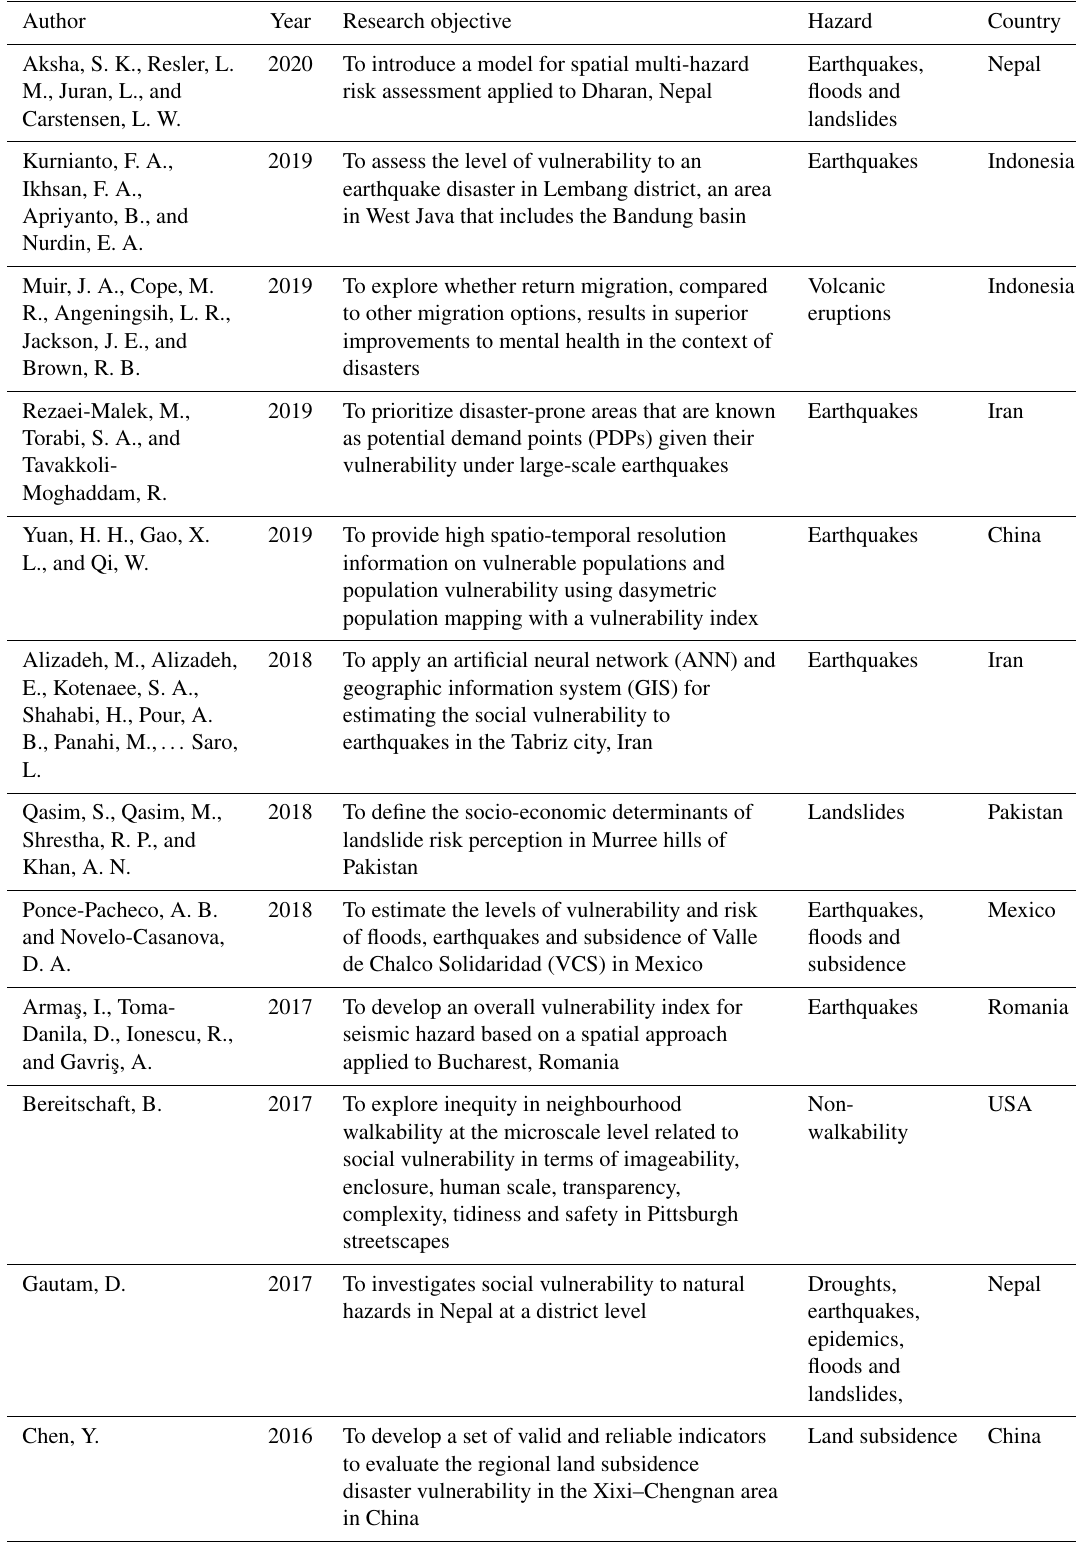
Table 2. Articles identified and selected by the systematic review.